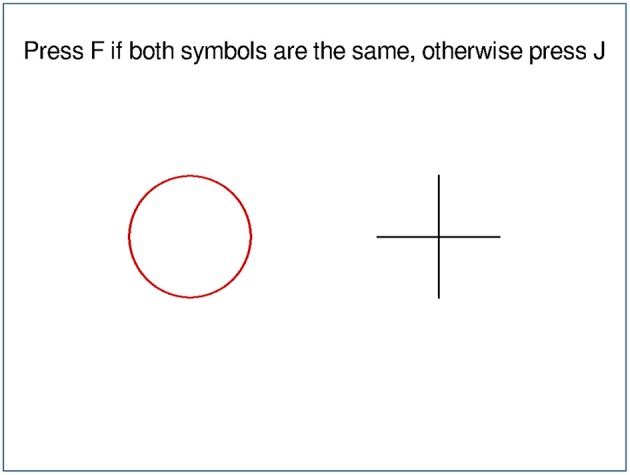
Screen of example 2.